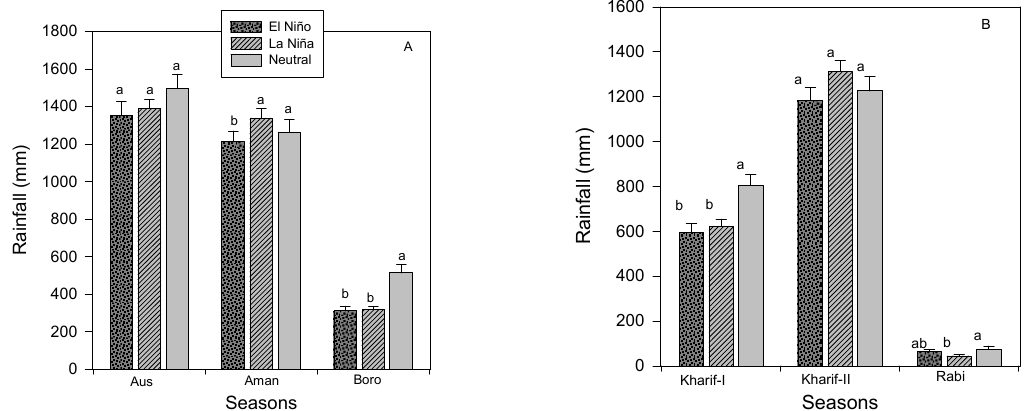
Figure 5. Impacts of ENSO signals on the amount of total rainfall composite during ( A ) Aus, Aman, and Boro, and ( B ) Kharif-I, Kharif-II and Rabi seasons for all selected stations in the coastal Bangladesh. Means that do not share same letters are statistically significant (Tukey’s b, α = 5%). The error bars represent the standard error of the means.